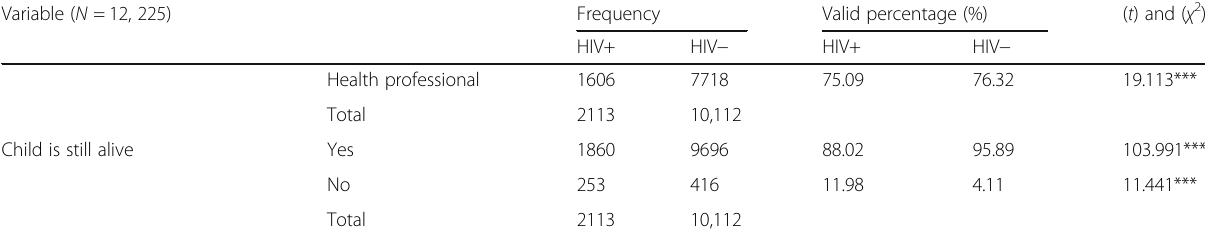
Table 1 Summary of characteristics (differences and similarities) between HIV-positive and HIV-negative populations (Continued) Variable ( N = 12, 225)